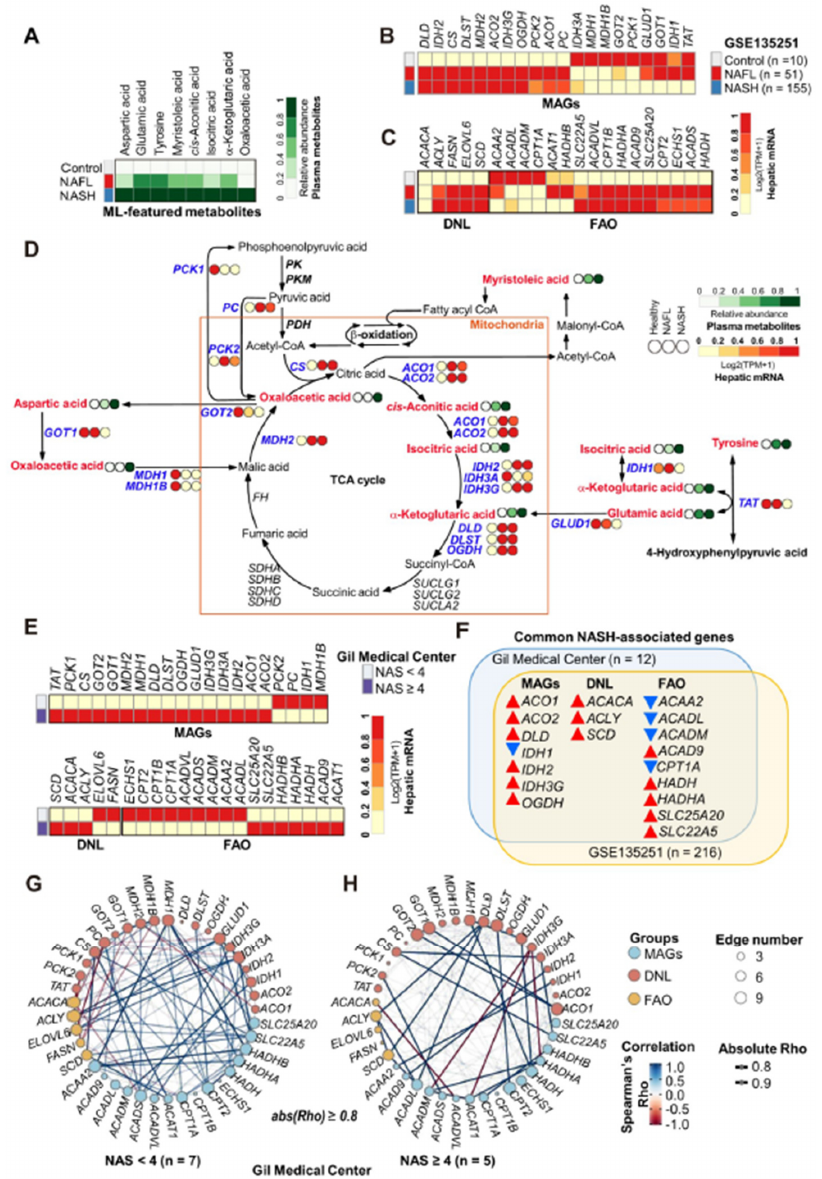
Figure 7. Multi-omics analyses presenting NASH-specific associations between ML-featured metabo- lites and their metabolic pathway-related genes. ( A ) Heatmap presenting the relative abundance of 8 ML-featured metabolites. ( B ) Heatmaps visualizing the relative expression of genes encoding enzymes governing metabolic pathways of ML-featured metabolites (MAGs). ( C ) Heatmaps visualiz- ing the relative expression of genes involved in hepatic DNL and FAO. The gene expression profiles presented in ( B , C ) are from the RNA-seq dataset (GSE135251) described in the “Results” section. ( D ) Integrative metabolic map summarizing the associations of ML-featured metabolites and their associated genes with NAFLD progression. ( E ) Heatmaps displaying the expression levels of hepatic transcripts of MAGs, DNL, and FAO in our own RNA-seq data according to NAFLD progression (NAS < 4 ( n = 7) versus NAS ≥ 4 ( n = 5). ( F ) Venn diagram summarizing commonly altered genes between the two datasets (our dataset and the public dataset). Red and blue arrows indicate up- and down-regulated gene expression in subjects with NASH compared to subjects without NASH, respectively. ( G ) Coexpression analysis in subjects with NAS < 4 (non-NASH) and ( H ) NAS ≥ 4 (NASH) based on Spearman’s correlation. Correlations with an absolute Rho above 0.8 or more are only visualized as edges. A blue edge indicates Rho ≥ 0.8, and a red edge indicates Rho ≤ − 0.8 with statistical